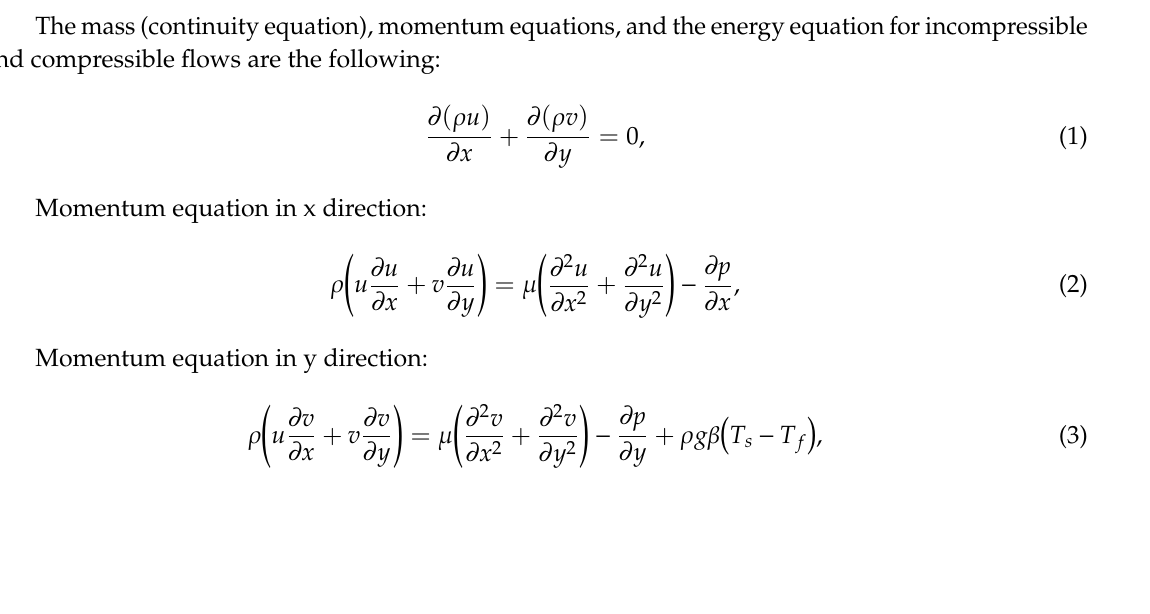
Figure 2. Arrangement of the tube arrays 4 × 4: ( a ) base configuration; ( b ) concave configuration; ( c ) convex configuration.